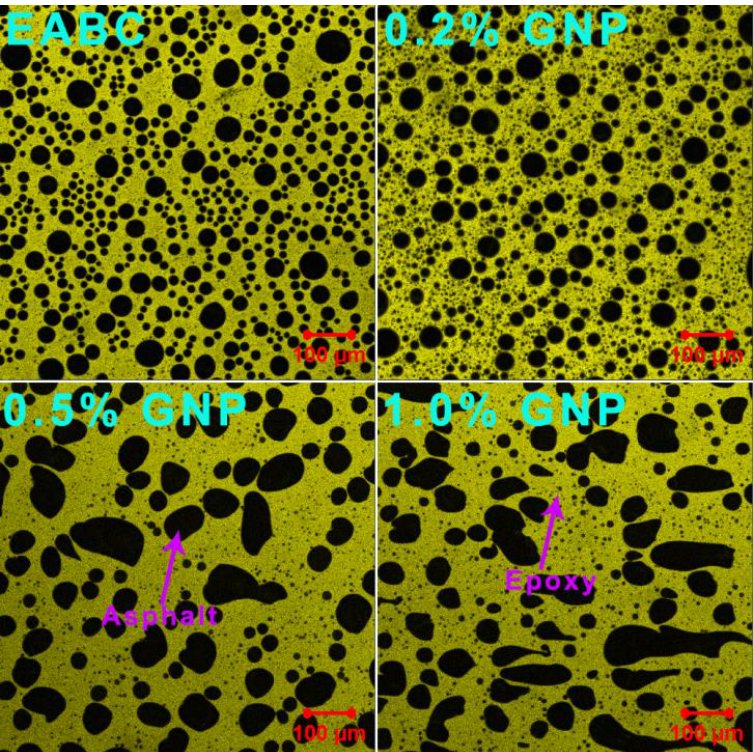
Figure 2. Fluorescence confocal microscopy images of GNP-modified EABCs.